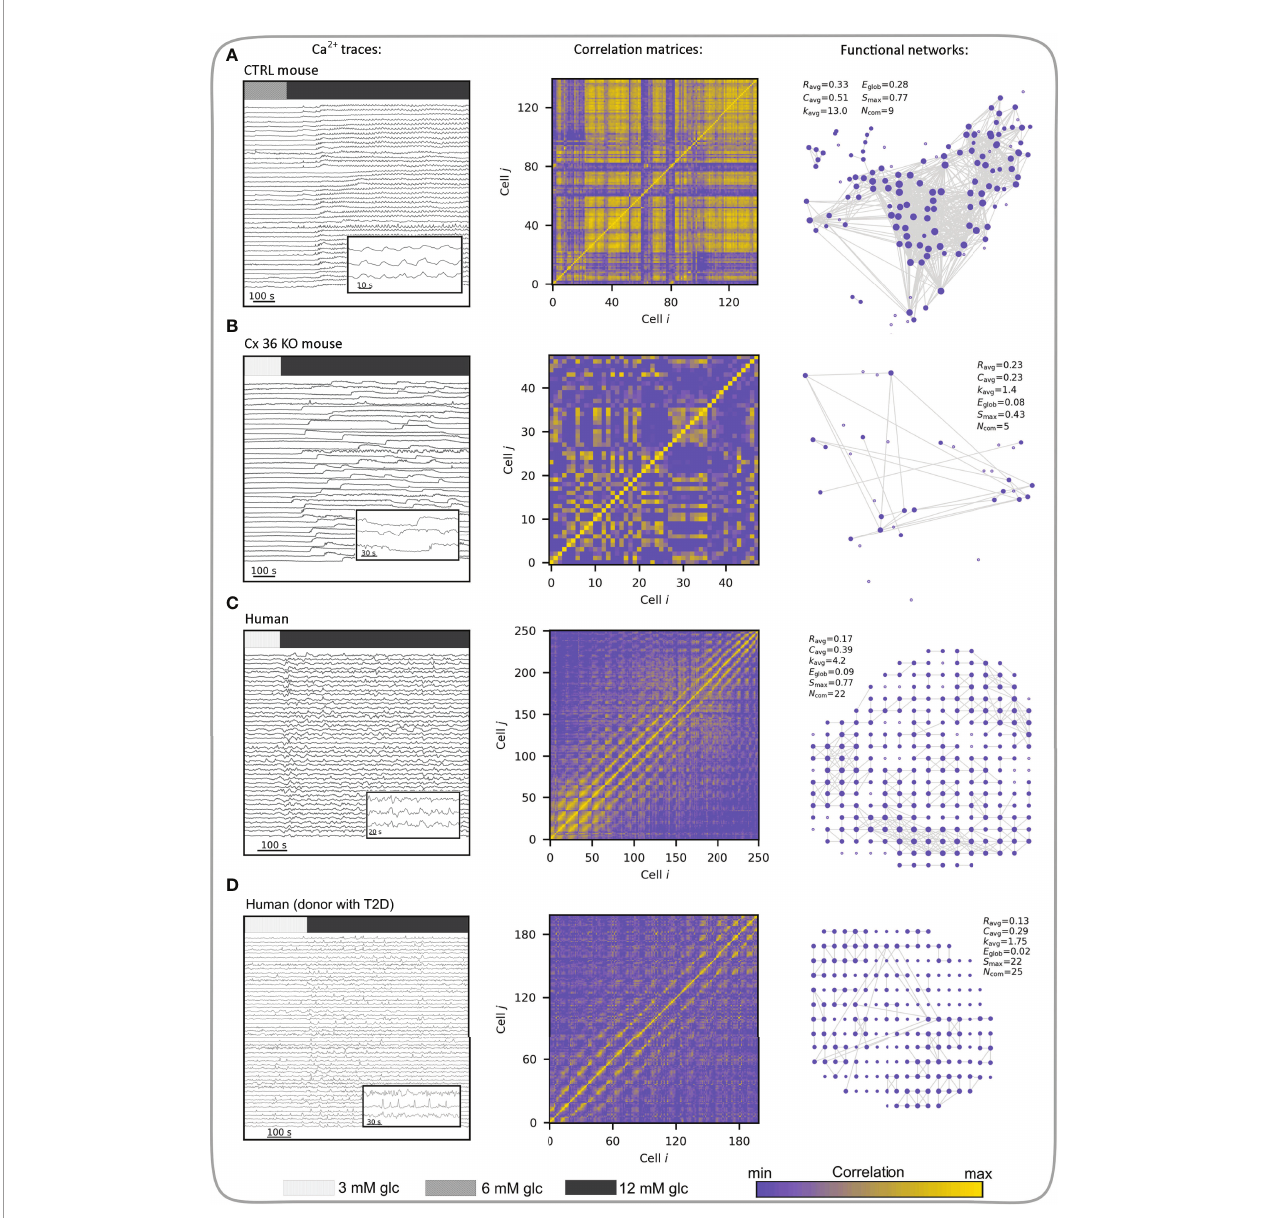
FIGURE 8 | Multicellular activity and functional connectivity maps in a control (wild type) mouse islet (A) , an uncoupled (Cx36 KO) mouse islet (B) , human islet from a normal donor (C) , and human islet from a donor with T2D (D) . Left column visualizes Ca 2+ activity with indicated stimulation intervals. Bars indicate 3- (light gray), 6- (gray) and 12- (dim gray) mM glucose stimulation. Note that 3 mM glucose was used as the substimulatory concentration in (B-D), as 6 mM can already evoke activity in these islets (unlike in control mouse islets). Inserts show short intervals of selected cellular signals. Middle column features the correlation matrices extracted from Ca 2+ signals. Correlation levels between cell pairs are color-coded as indicated with the color bar (the same scale refers to all four panels). In the right column the corresponding functional networks are presented, which were obtained by thresholding the correlation matrices ( R th = 0.7). Along with networks, the key parameters are provided: average correlation ( R avg ), average clustering coef fi cient ( C avg ), average network node degree ( k avg ), global ef fi ciency ( E glob ), largest connected component ( S max ), and the number of communities ( N com